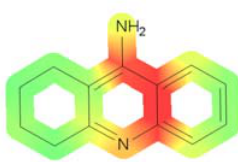
Figure 3. Visualization of the genotoxic properties for tacrine. Hazardous substructures (genotoxic fragments) are colored in red.